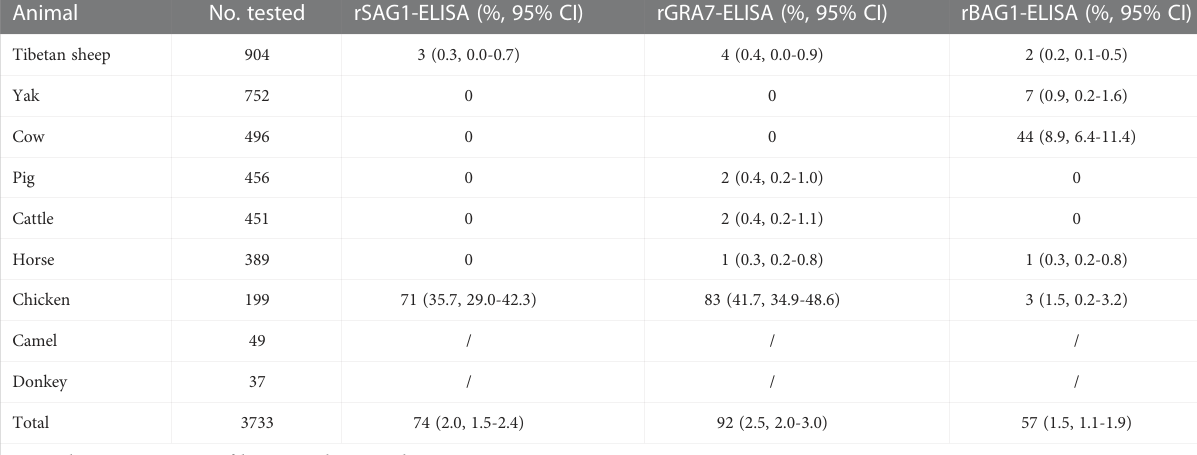
%, Prevalence. 95% CI, 95% Con fi dence Interval./, no tested.